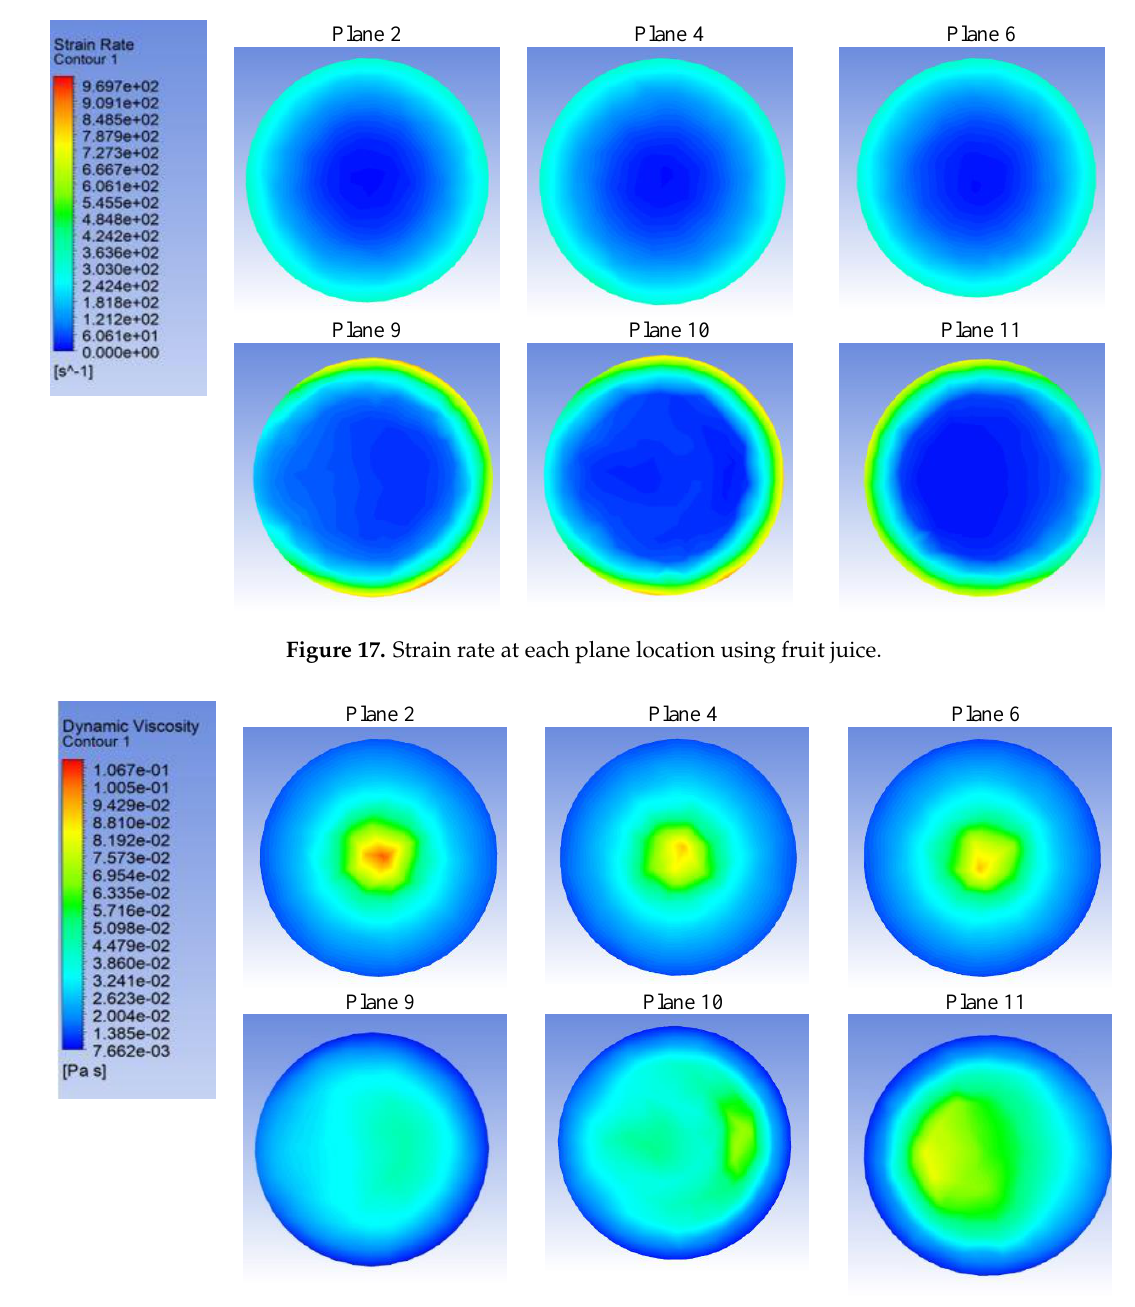
Figure 18. Dynamic viscosity at each plane location using fruit